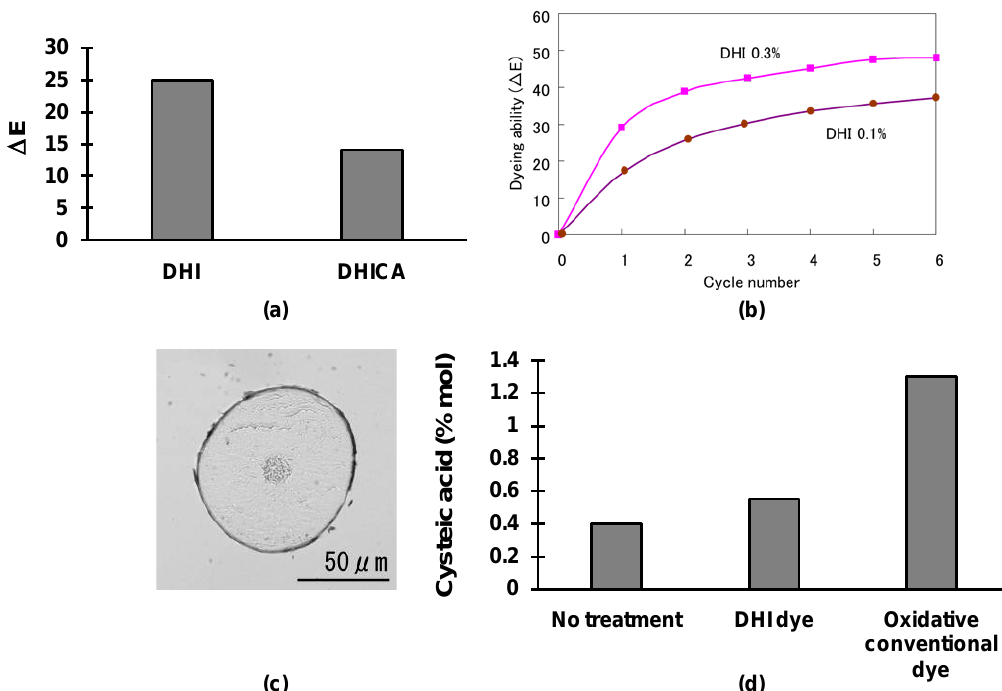
Figure 3. Development of DHI-based hair dye. ( a ) Comparison of the dyeing performance of melanin precursors. Dyeing level (∆E) represents the difference of the color measured with a CR -400 (Minolta, Japan) color photometer before and after three times treatment of 1 g of Japanese gray hair tresses treated for 5 min with 1 g of a solution containing 3% ammonia, and 0.1% melanin precursor at room temperature; ( b ) Dyeing ability of the DHI hair dye on gray hair. The hair dye contained 0.1 or 0.3% melanin precursor (DHI), 1% alkaline agents (2-aminoethanol), 10% organic solvents (ethanol and butylene glycol), 0.5% a thickener (acrylates/C10-30 alkyl acrylate crosspolymer), 0.5% silicones (dimethicones and amodimethicones), 1.5% nonionic surfactant (Polyoxyethylene (9) dodecyl ether), 0.5% antioxidants (ascorbic acid and sodium sulfite). 1 g of gray hair tresses were treated with 1 g of a dyeing formulation, left for 5 min at room temperature, shampooed twice, and dried with a hair dryer. This cycle was repeated up to six times. Dyeing ability ( ∆ E) defined as in ( a ); ( c ) Cross section microgram of the gray hair after eight treatments; and, ( d ) Levels of cysteic of hair samples treated with DHI based dye (five treatments) or with conventional hair dyes.